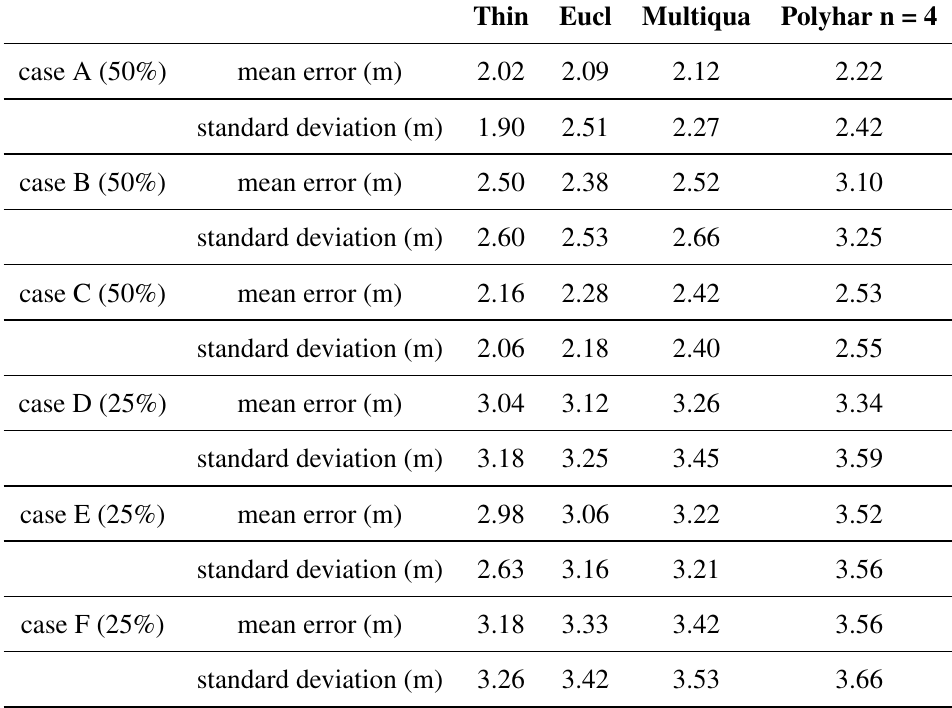
Table 2. Average localization accuracy with different interpolation functions (thin spline, euclidean, multiquadratic and polyharmonic with n = 4) and percentage of reference points: 50% and 25%. In both cases, three different selections of the interpolated points are